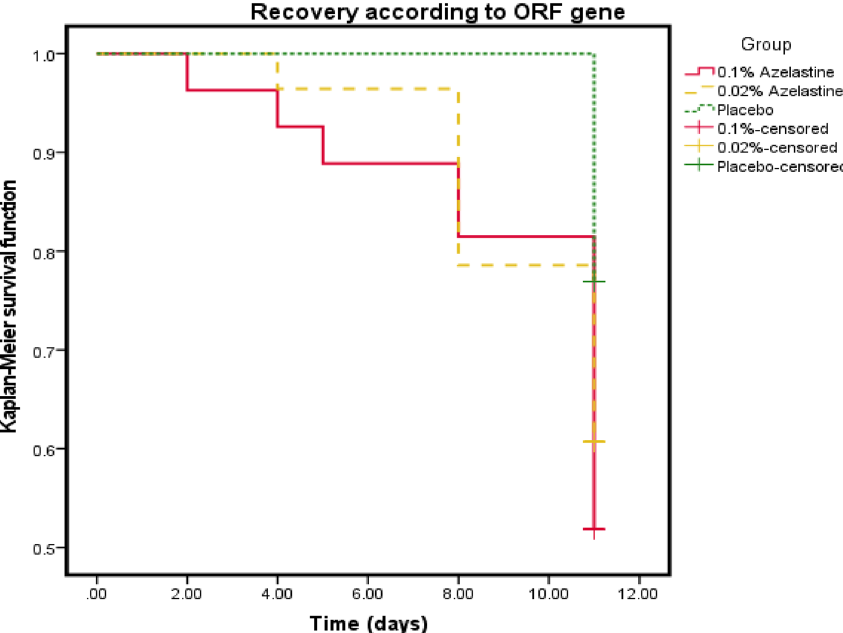
Figure 5. Kaplan–Meier analysis results regarding the ORF 1a/b gene from baseline (day 1) until day 11 of treatment (ITT analysis